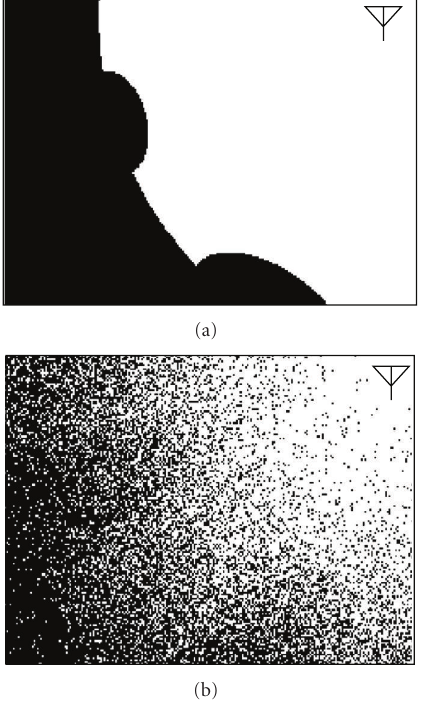
Figure 18: Examples of a binary channel (white areas indicate that channel quality is above an acceptable threshold whereas black areas denote otherwise)—(a) channel generated based on knowing the positions of the obstacles and considering only shadowing and path loss and (b) the same channel after adding Rician-distributed